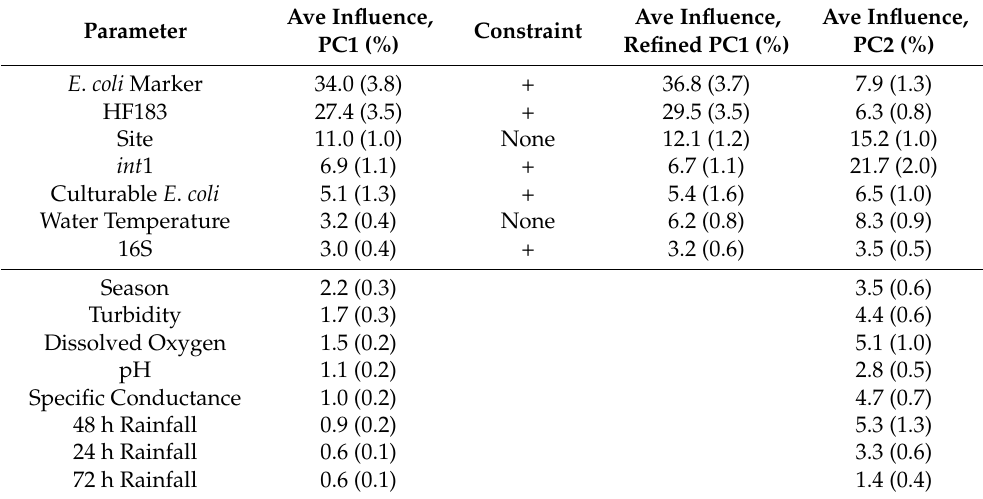
Table 3. Average influence of the predictor variables for the PC1, Refined PC1, and PC2 models based on 500 GBM runs for each. Standard deviations are in parentheses. The 7 predictors above the dotted line were retained and included in the Refined PC1